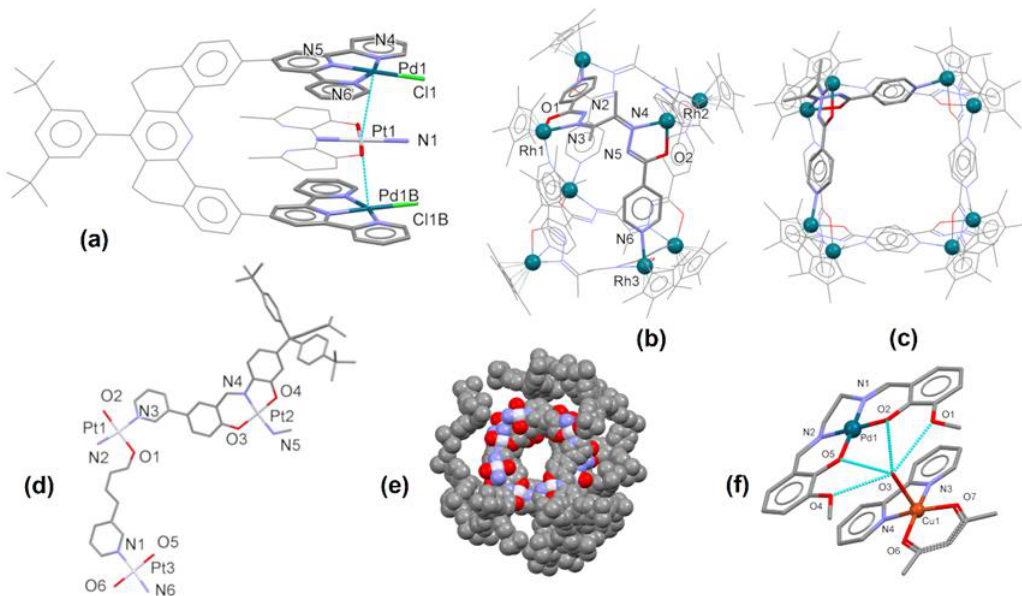
Figure 13. ( a ) Intermetallic contacts between Pd and Pt atoms in a host – guest adduct of a tweezer type dipalladium complex and a neutral platinum species [190] (CSD Refcode JAJWIB); ( b ) half sandwich M 8 (L) 4 cubic cage of rhodium (L = 2,3-butanedione bis(isonicotinyl hydrazine)) ( c ) and a side view [191] (CSD Refcode UROREA); ( d ) one of oligonuclear Pt coordination units ( e ) and a view at nanotubular macrocycle aggregate presented as van der Waals spheres [192] (CSD Refcode BEHVUH) and ( f ) supercomplex built of square planar coordination entities acting as host receptors for aqua ligands coordinated by another coordination unit [193] (CSD Refcode TEGBUD). Hydrogen atoms, solvent and counterion molecules were omitted for clarity.